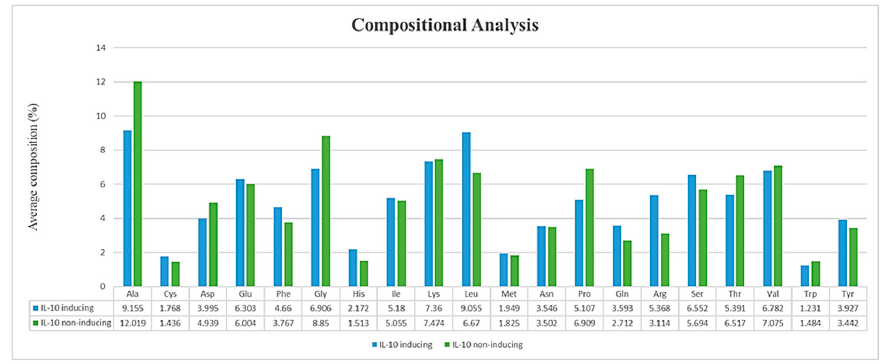
Figure 3. Average percentages of amino acid compositions (AACs) in IL-10-inducing peptides and non-IL-10-inducing peptides.